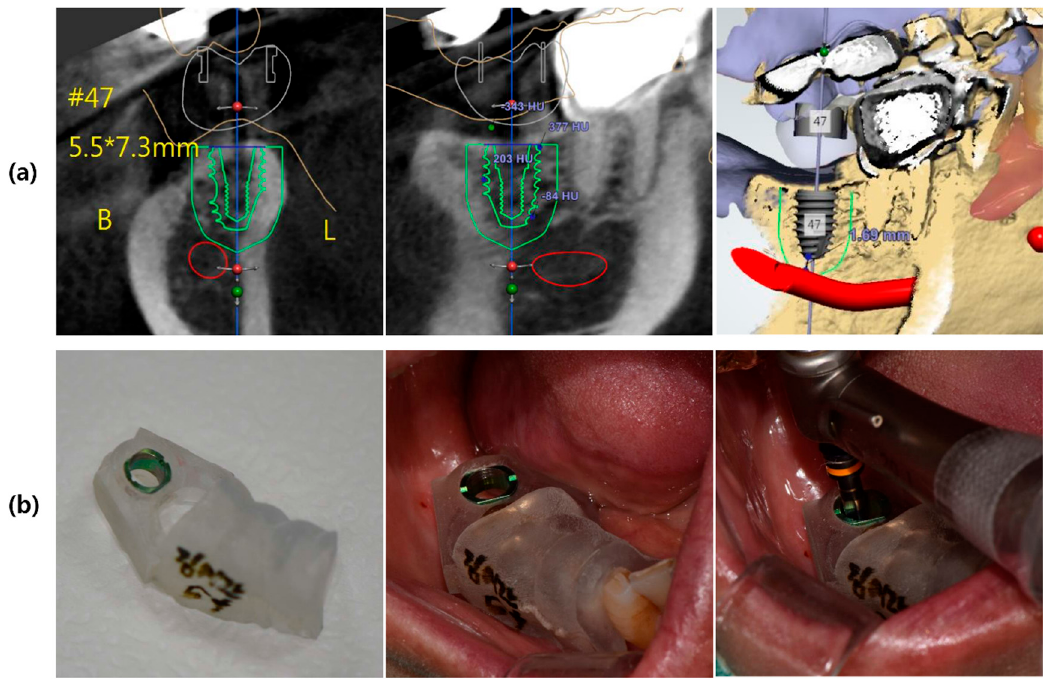
Figure 2. Computer aided surgery ( a ) 3D digital implant planning with software, ( b ) surgical template.